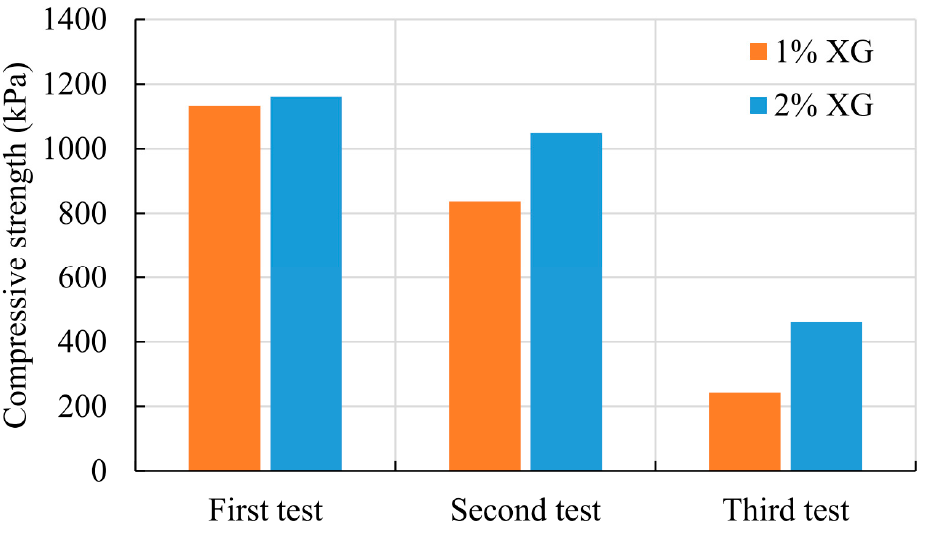
Figure 7. Compressive strength of regenerated sand XG-treated